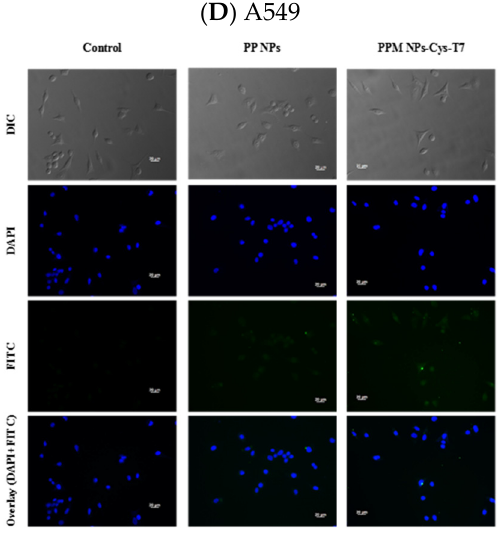
Figure 6. Fluorescence microscopic images of ( A ) MDA-MB-231, ( B ) SKOV-3, ( C ) U87-MG and ( D ) A549 cells treated with free medium only (left) and FITC-labeled PP NPs (middle) and PPM NPs-Cys-T7 (right). The blue spots indicate the nuclei stained with DAPI, and the green signals present the FITC-labeled NPs. (400×, scale bar 20 µm).